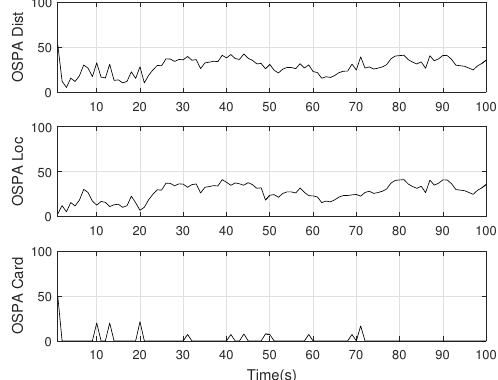
Figure 16. The OSPA distance by Gibbs-GLMB filter.